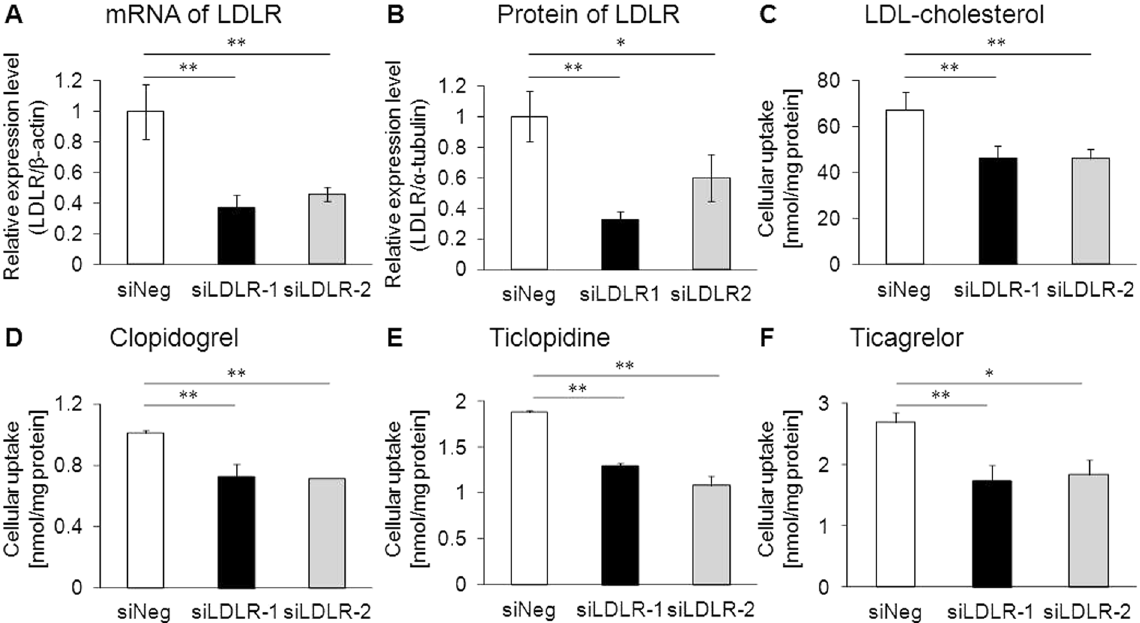
Figure 4. Effect of LDLR knockdown on LDL-mediated drug transport in vitro . (A) Messenger RNA levels and (B) protein levels of LDLR in control (siNeg) and LDLR-knockdown (siLDLR-1 and siLDLR-2) cells as determined by quantitative real-time PCR and western blotting, respectively. (C) The uptake of reconstituted LDL containing [ 3 H]cholesterol in FBS-free transport buffer was measured in siNeg, siLDLR-1, and siLDLR-2 cells. (D–F) In vitro uptake experiments of (D ) clopidogrel, ( E ) ticlopidine, and ( F ) ticagrelor in reconstituted LDL in siNeg, siLDLR-1, and siLDLR-2 cells. Bars represent the mean ± s.e.m. * p < 0.05, ** p <